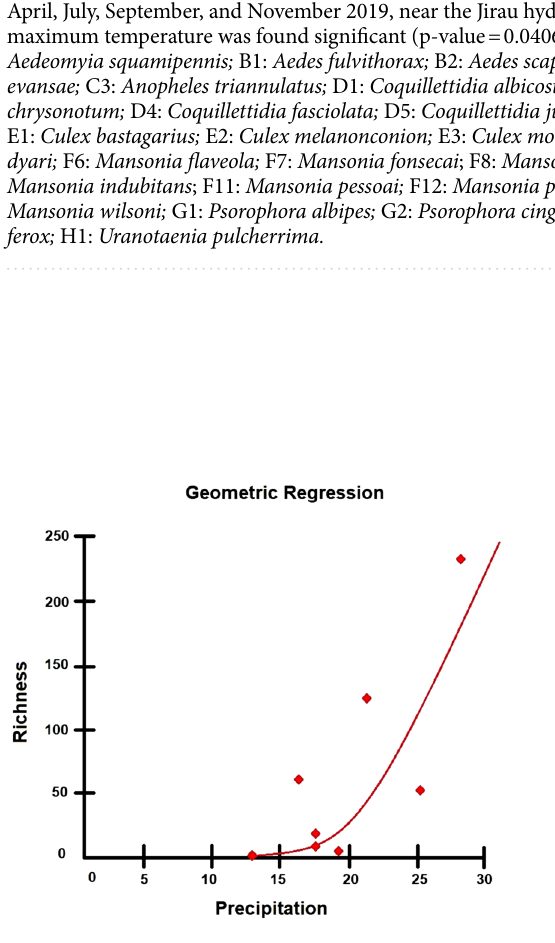
Figure 3. Regression curve of geometric regression (p-value = 0.0272, R 2 = 58.39%) of species richness as a function of cumulative precipitation, indicating a positive correlation between these two